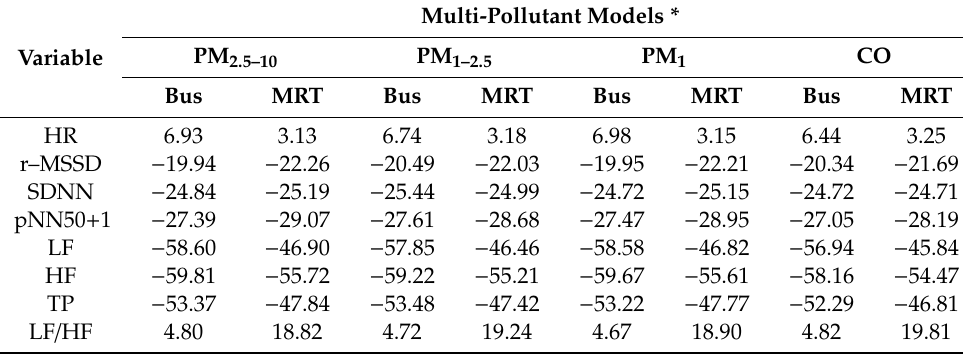
Table 5. Impact of microenvironmental personal exposures in public transportation on HRV indices. Multi-Pollutant Models Variable